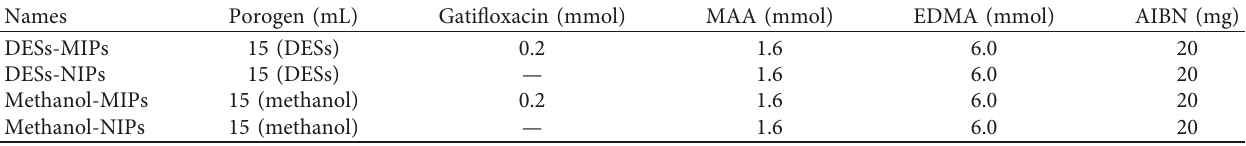
Table 1: Recipes of resultant